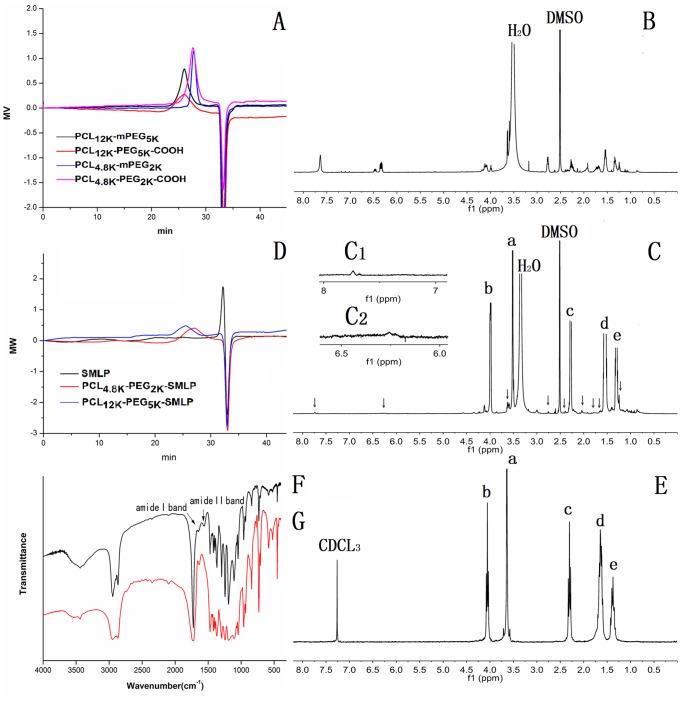
The gel permeation chromatography graphs of four copolymers (A) and SMLP,PCL4.8K-PEG2K-SMLP and PCL12K-PEG5K-SMLP (D), the representative 1H NMR spectra of SMLP (B), copolymers PCL12K-PEG5K-SMLP (C) containing SMLP (black arrows) and PCL12K-PEG5K-COOH (E) with the peaks of PCL12k-PEG5k segment (a-e) and Infrared spectra graph of PCL12k-PEG5k-SMLP (F) and PCL12K-PEG5K-COOH (G) copolymers.